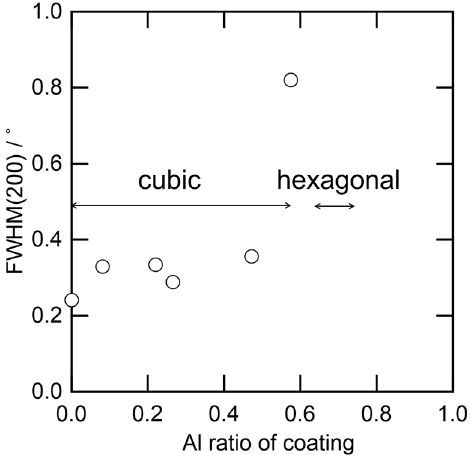
Figure 12. Relationship between Al ratio of the coating and FWHM of (200) peak of B1 phase .